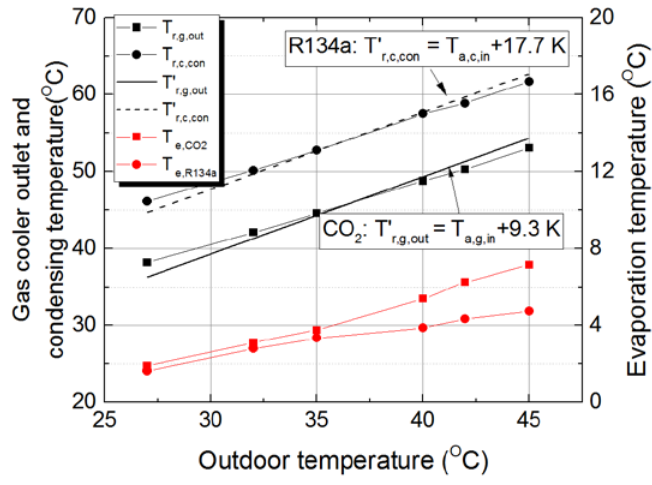
Figure 5. The gas cooler outlet, condensing temperature, and evaporation temperatures at varied outdoor temperatures.